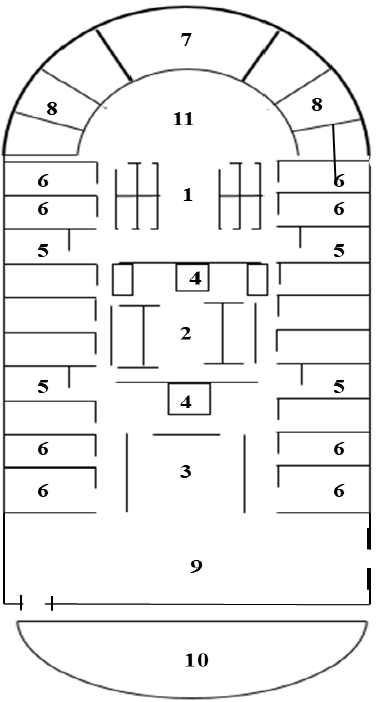
Figure 12. Dragon House floor plan. 1—Upper Hall; 2—Middle Hall; 3—Lower Hall; 4—Patio; 5—Hengwu Hall; 6—Hengwu Room; 7—Dragon Room; 8—Enclosed Room; 9—Heping; 10—Pond; 11 — Flower Tire.